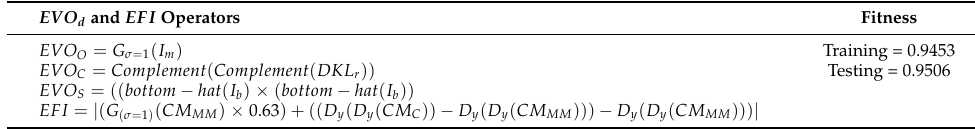
Table 10. Program structure of the operators corresponding to the best solution for the FT database. We select this solution from the 30 executions of Table 9. The final solution is more complex than the previous experiments. Still, the program is interpretable. The first visual operator applies a filter, while the second computes two times the complement of DKL r . Then, the shape operator applies a multiplication between bottom-hat operations to I b . Finally, the feature integration uses filters and derivatives to the conspicuity maps using algebraic operations.